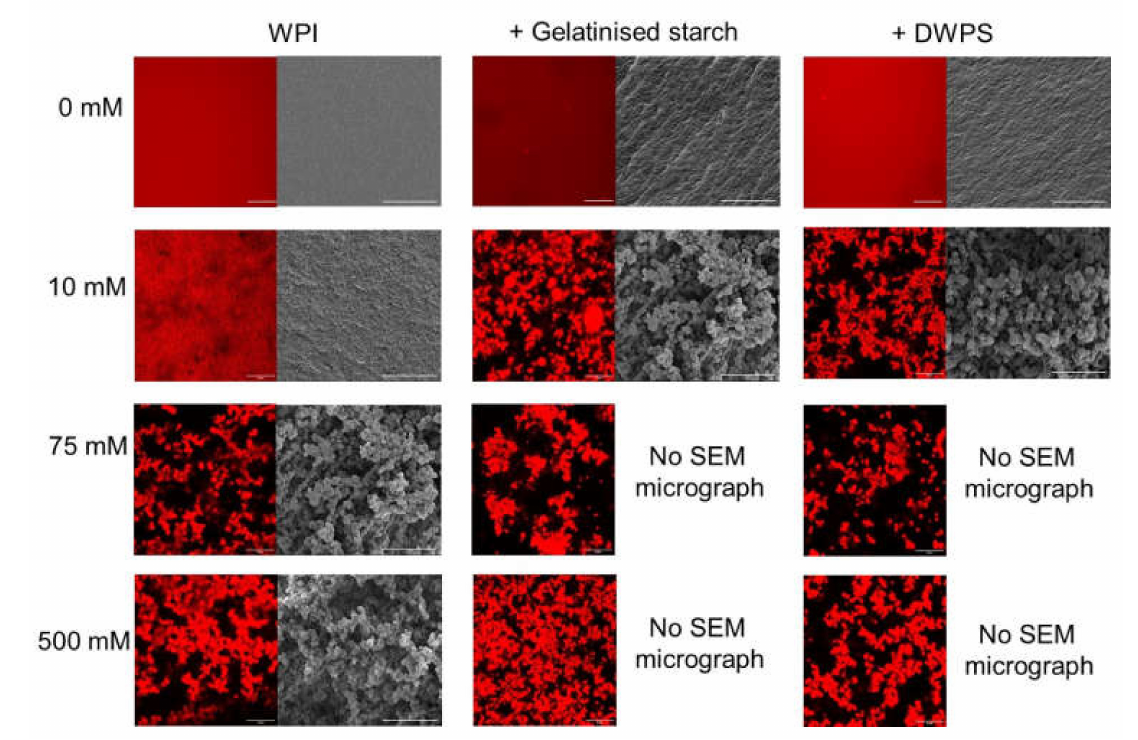
Figure 6. Effect of CaCl 2 on the CSLM micrographs (630 × ) and SEM micrographs (2500 × ) of 13% w / w WPI and 13% w / w WPI + 4% w / w gelatinised starch or DWPS gels at 0, 10, 75, and 500 mM CaCl 2 . Note that SEM was not done for paste-like samples. The scale bars are 20 µ